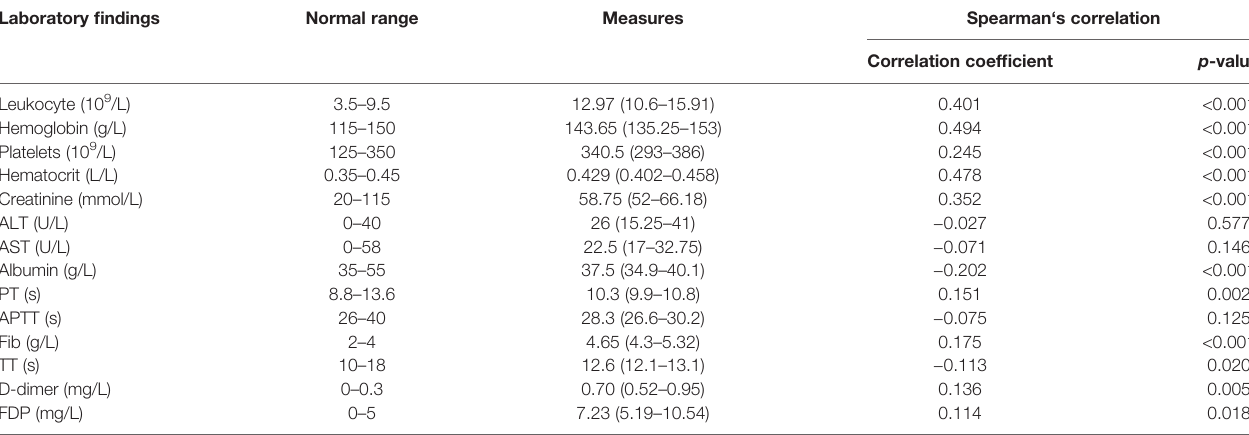
TABLE 3 | Relationship between the laboratory fi ndings and recovery time of patients with ovarian hyperstimulation syndrome (OHSS). Laboratory fi